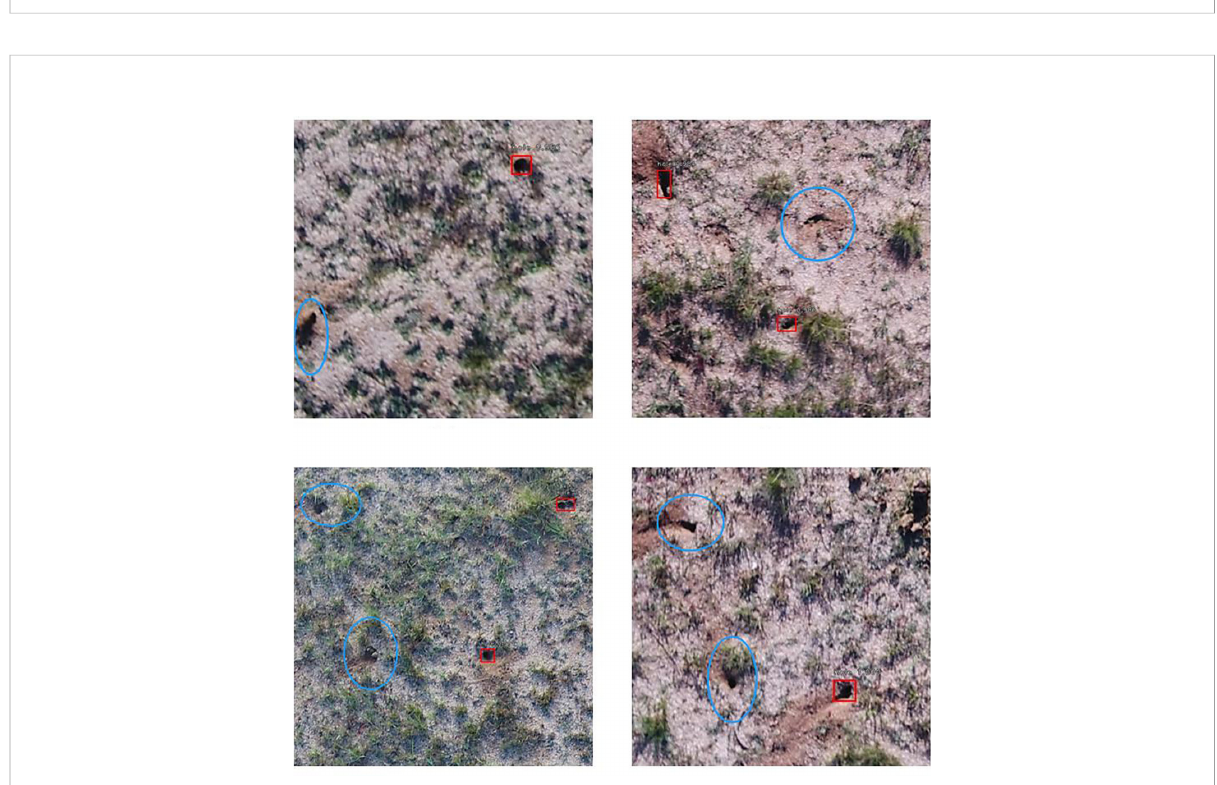
FIGURE 9 Examples of False Negative (FN) (in blue circles). Predicted BV holes are in red